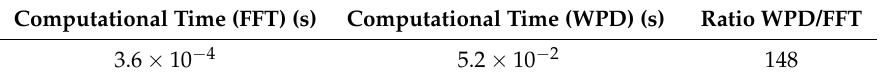
Table 3. Comparison of the average computational time for both methods on the same